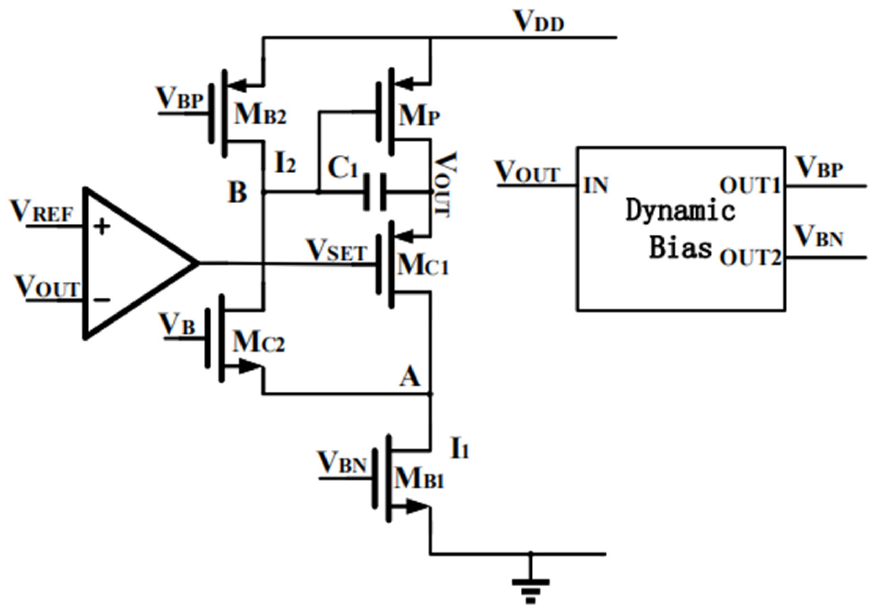
Figure 4. Proposed LDO circuit structure.